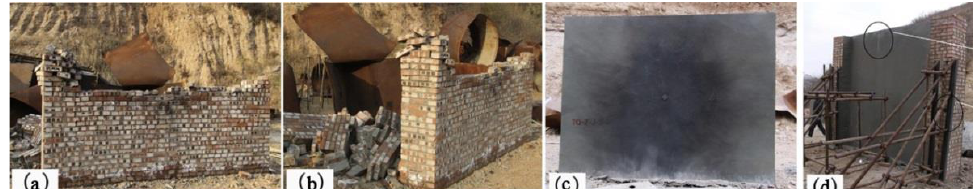
Figure 10. Comparison of unreinforced and reinforced masonry wall: ( a ) front of unreinforced ma- sonry wall; ( b ) side of unreinforced masonry wall; ( c ) front of polyurea-reinforced masonry wall; ( d ) side of the polyurea-reinforced masonry wall. Reproduced with permission from ref. [108].